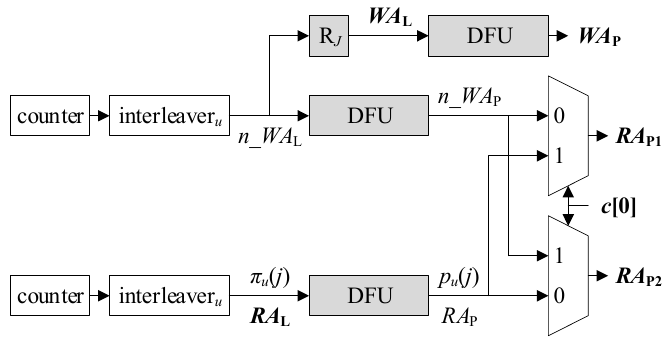
Figure 4. Interleaved-address-based AGU (I-AGU).